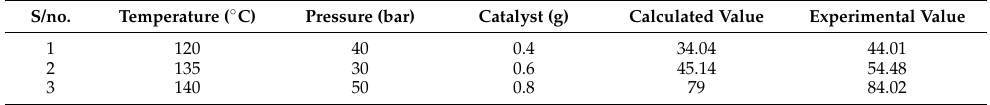
Table 4. Validation of the regression model.